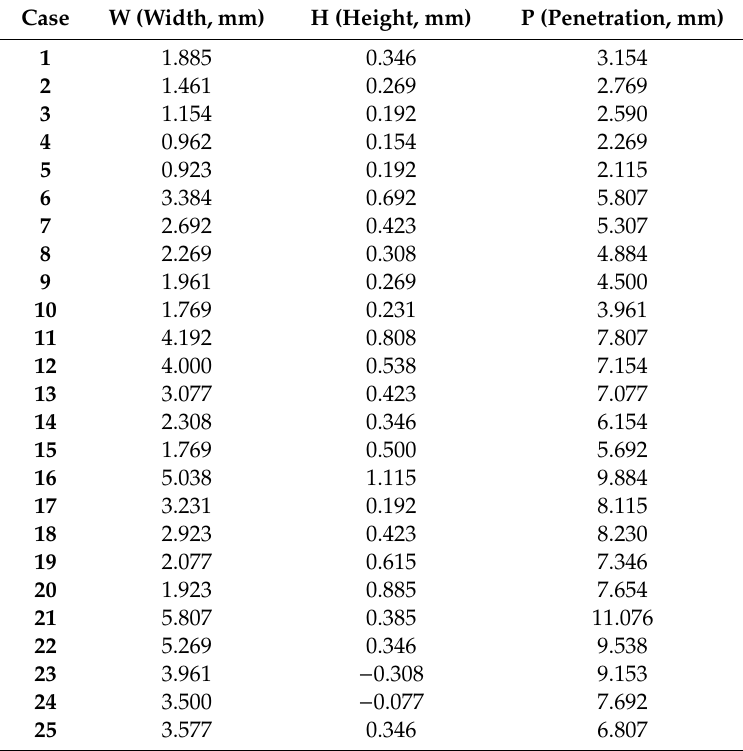
Table 4. Experimental conditions of laser BOP.